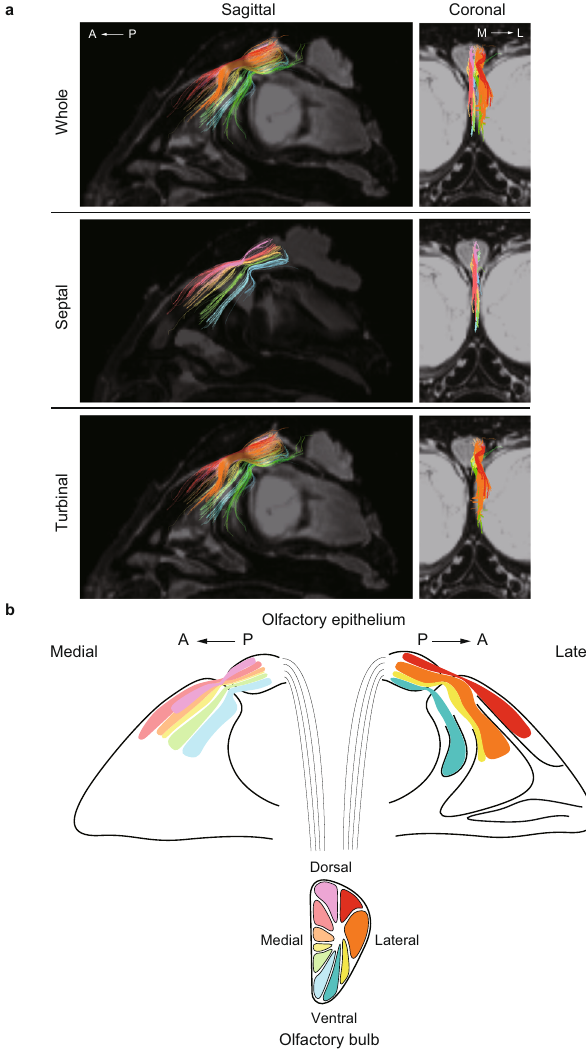
Fig. 5 The topographical relationships of the olfactory nerves running between the olfactory epithelium and olfactory bulb of the common marmoset. a Sagittal and coronal sections depicting the nerve pathways from the olfactory epithelium to the olfactory bulb. The fi bers are colored separately according to each olfactory fi lament. The Whole panels show all the depicted fi bers, while the Septal and Turbinal panels show the septal and turbinal fi bers, respectively. A anterior, L lateral, M medial, P posterior. b Schematic diagram showing the DTT-based olfactory nerve map for the marmoset (the distribution of the olfactory nerves running between the olfactory epithelium and olfactory bulb). Topographically, there was a correlation between the distributions in the olfactory epithelium and olfactory bulb in both the dorsal-ventral and medial-lateral axes. A anterior, P